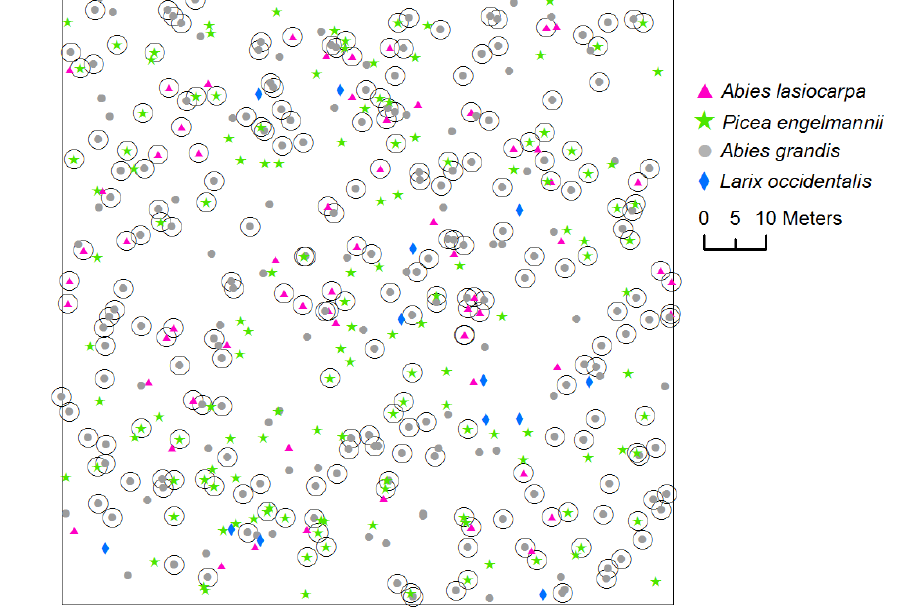
Figure 6. Map of the harvest tree locations (circled) assuming unique tree species in the species mingling index computation, for the uneven-aged mixed-conifer stand in eastern Oregon (western United States). The initial threshold was 0.003; the rate of change was 0.9975; and the iterations per threshold were